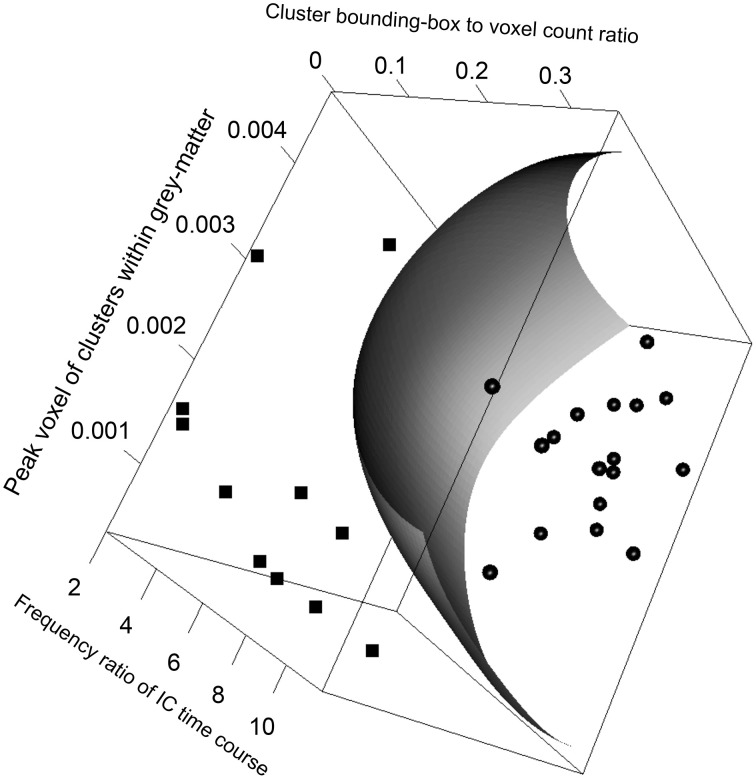
Visualizing the FOCIS classification model as a dividing hyper-plane in 3D feature space projected onto its 3 dimensions with greatest variances.